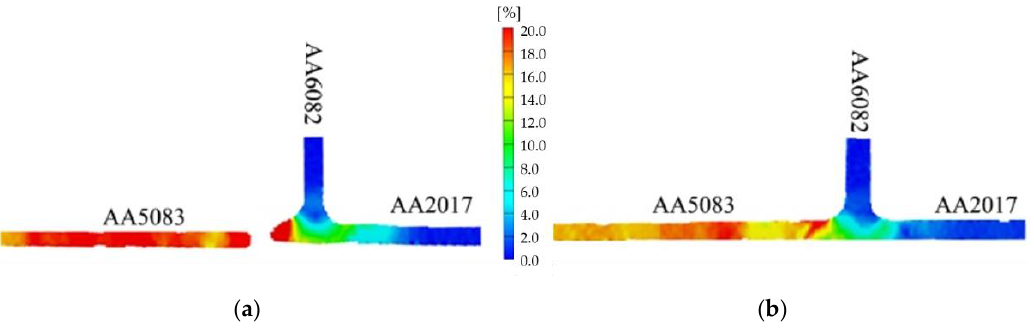
Figure 13. Strain distribution in tensile test specimens close to failure from the ( a ) 562-30 and ( b ) 562-120 series.